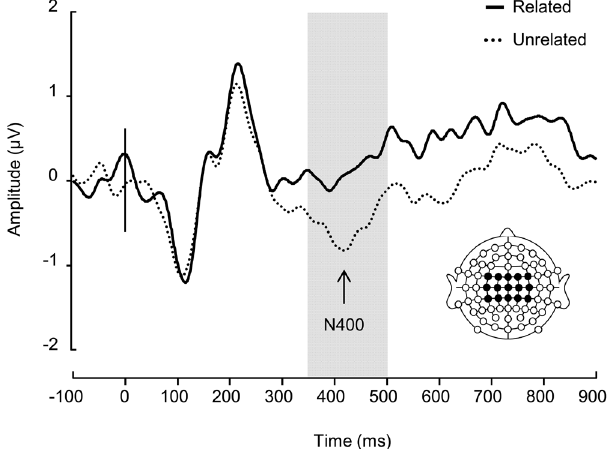
Figure 2. Grand average ERP waveforms. The average of 9 frontocentral, central, centroparietal electrodes (FC1-4 & Z, C1-4 & Z, & CP1-4 & Z). Word onset is indicated with the vertical line at 0 ms. The grey shaded area indicates the N400 with a more negative amplitude elicited by unrelated than related words.